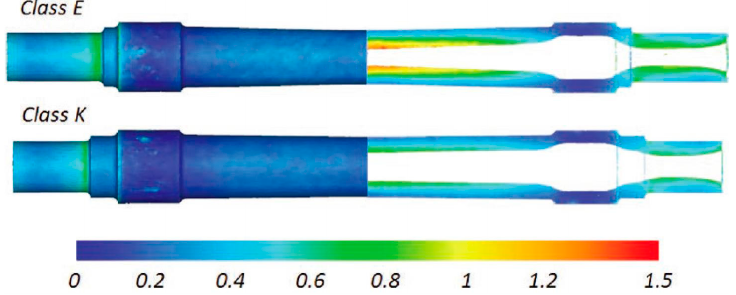
Figure 12. Numerically simulated distribution of damage function in cross-rolled rail axles [10] (Reprinted from ref. [10]).